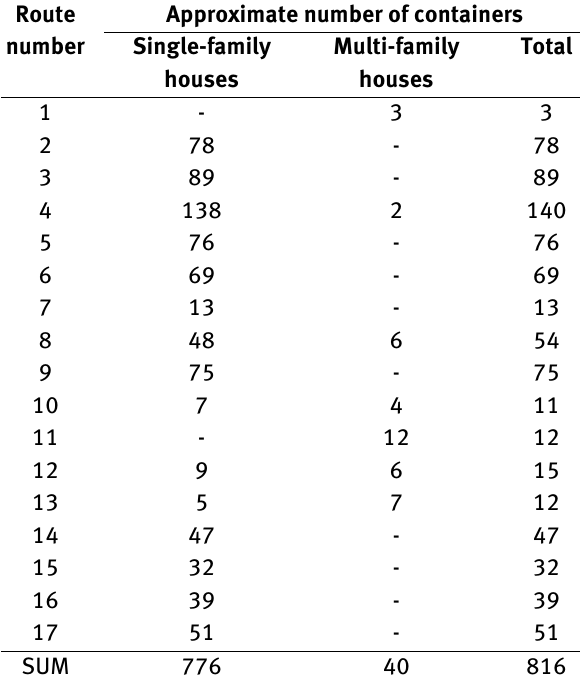
Table 1: Waste collection points on individual routes